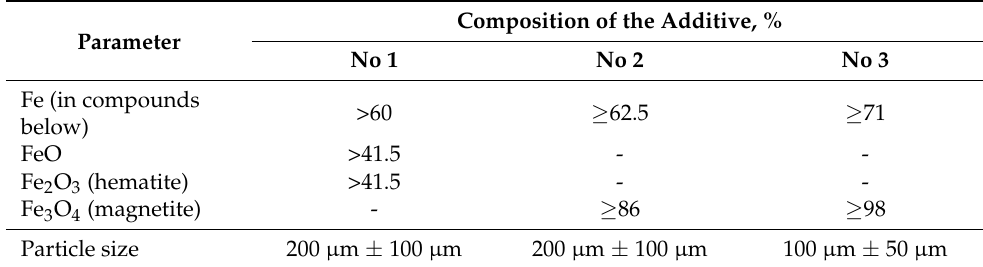
Table 1. Chemical composition and particle size of the additives.